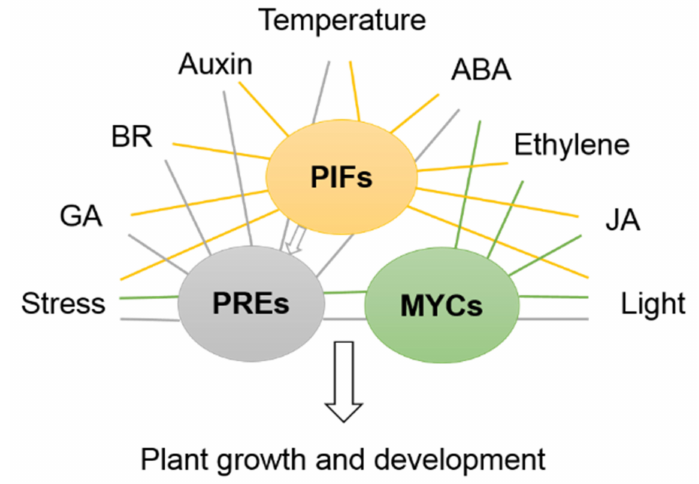
Figure 2. Simplified model for bHLH PREs, MYCs and PIFs, which play central roles in many pathways in Arabidopsis. PIFs bind to their target genes to regulate plant growth and development via manipulation of signaling pathways. PREs and MYCs also participate in core transcription networks together with PIFs to control plant responses to the